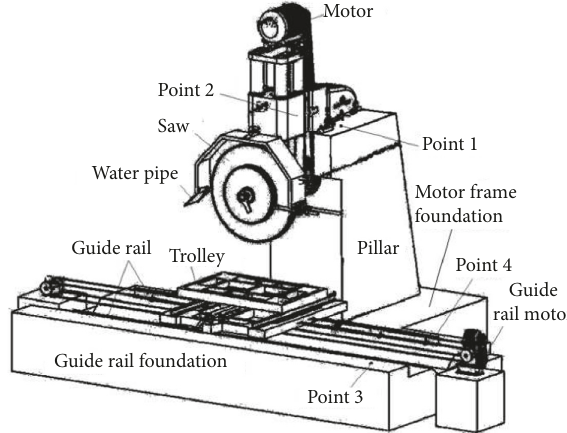
Figure 1: Sketch of foundation of stone cutting machine and measuring